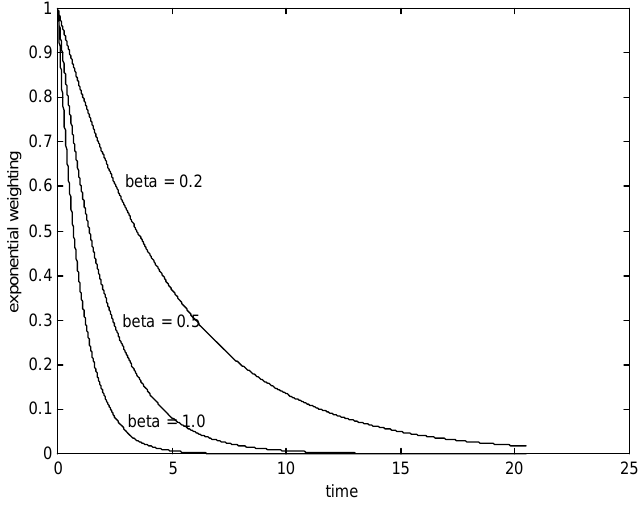
Fig. 2. Effect of β on the Exponential Weighting Function.